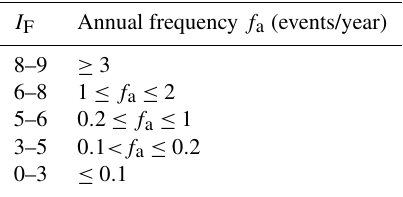
Table 4. Annual frequency f a for different I F